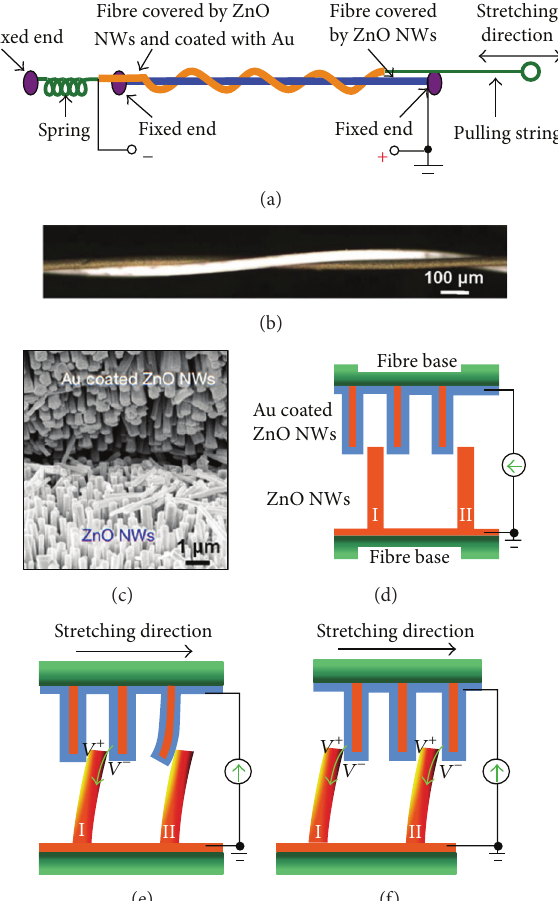
Figure 4: Design and electricity-generating mechanism of the fibre-based nanogenerator driven by a low-frequency, external pulling force. (Reproduced from [21] with the permission of Nature Publishing